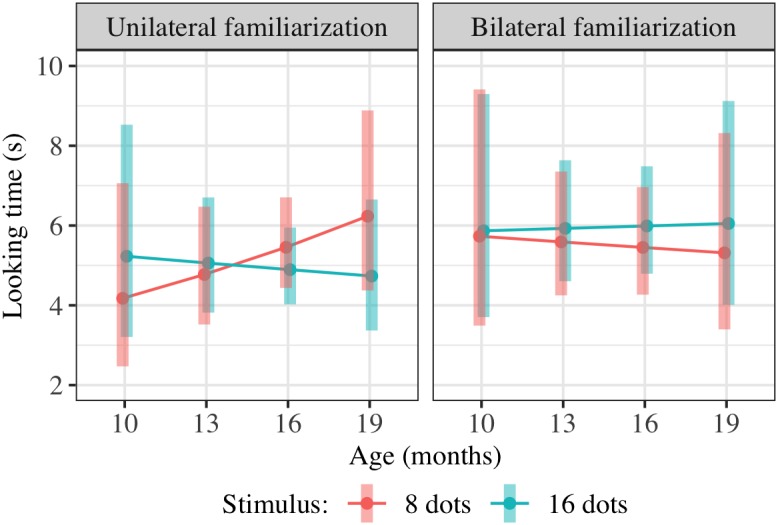
Interaction plot of estimated marginal means across combinations of familiarization condition and stimulus type over a set of reference ages spanning the tested age range, based on the linear mixed-effects model fitted for Experiment 2. Shaded error bars show 95% confidence intervals.